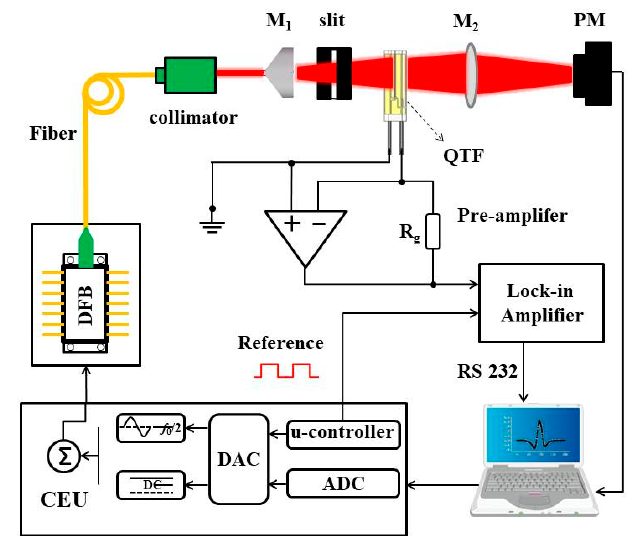
sensing system. M 1 : Powell lens; M 2 : Convex lens; PM: power meter and CEU: control electronics